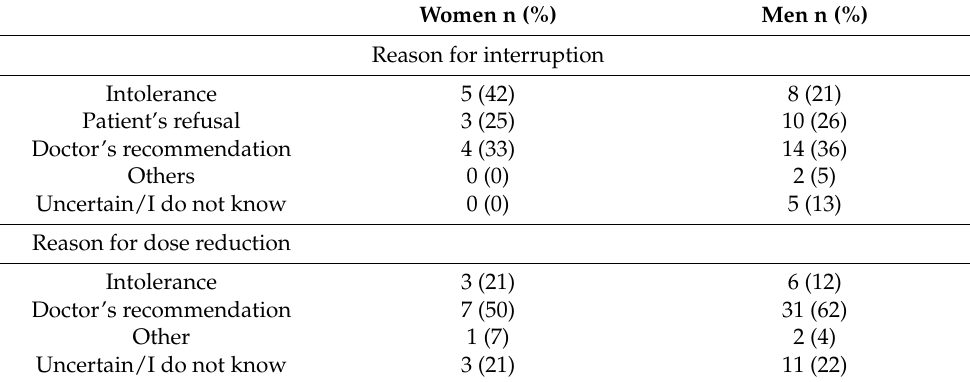
Table 8. Reasons for discontinuation of statin therapy and statin dose reduction. P value in all cases was insignificant due to the small number of